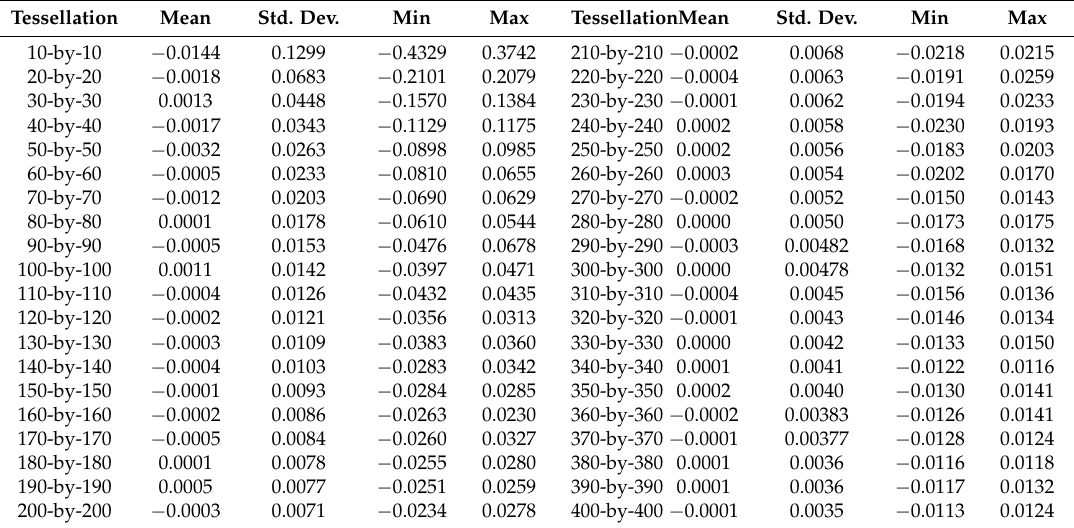
Table A1. Estimates of the spatial autocorrelation parameter ( ρ ) for increasing tessellation size based upon 1000 simulation replications and the standard normal distribution.